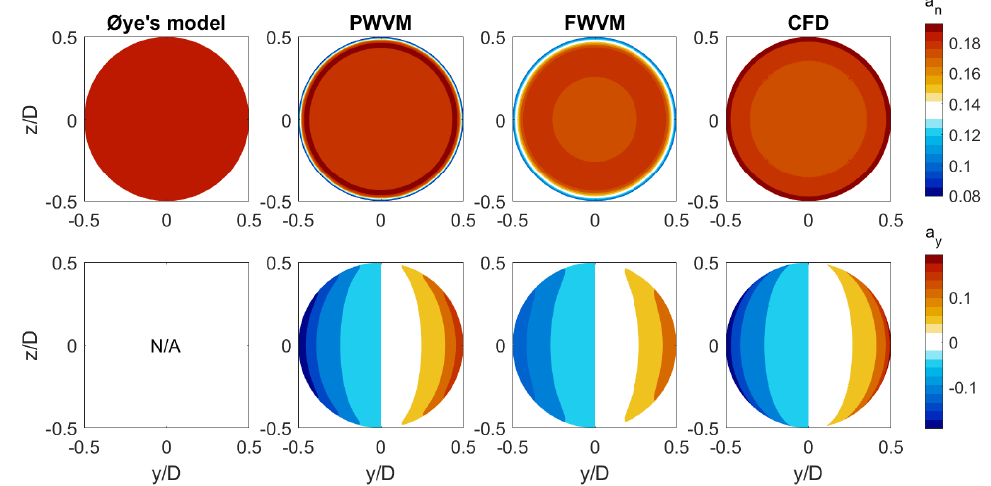
Figure 3. Induction field at the actuator disc on the axis normal to disc and y axis from different models when yaw angle = 0 deg and C T =